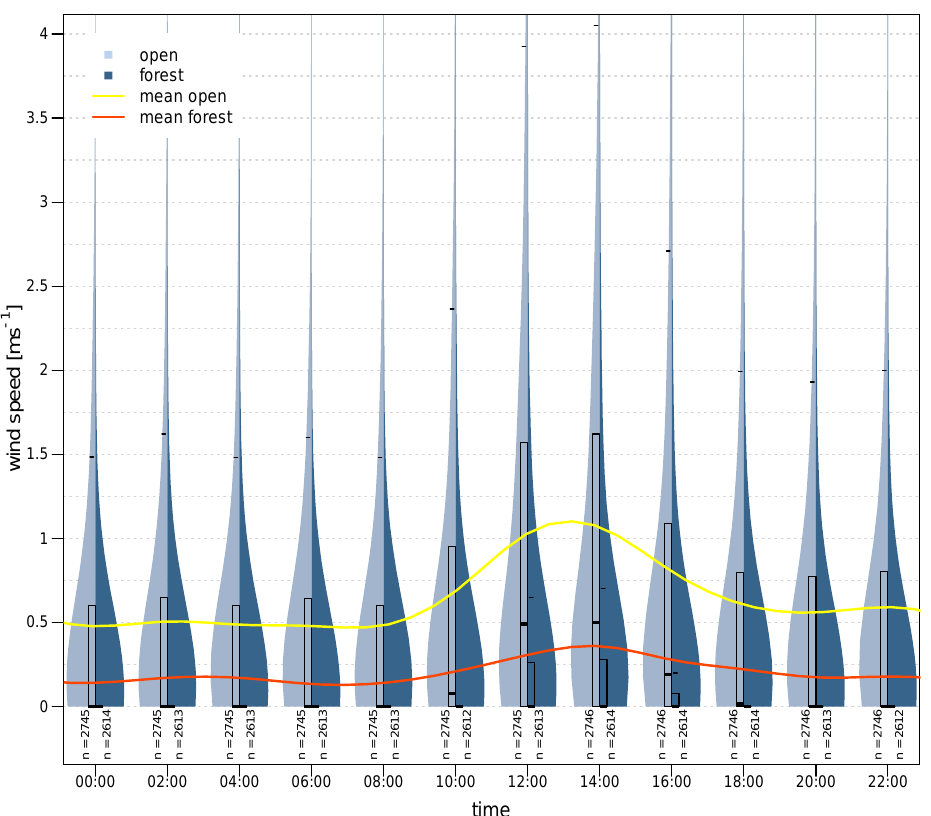
Figure 7. Diurnal wind speed course in comparison for open field stations and forest stations. Only days with temporal differences above 10 K are considered. teria than for both new approaches.